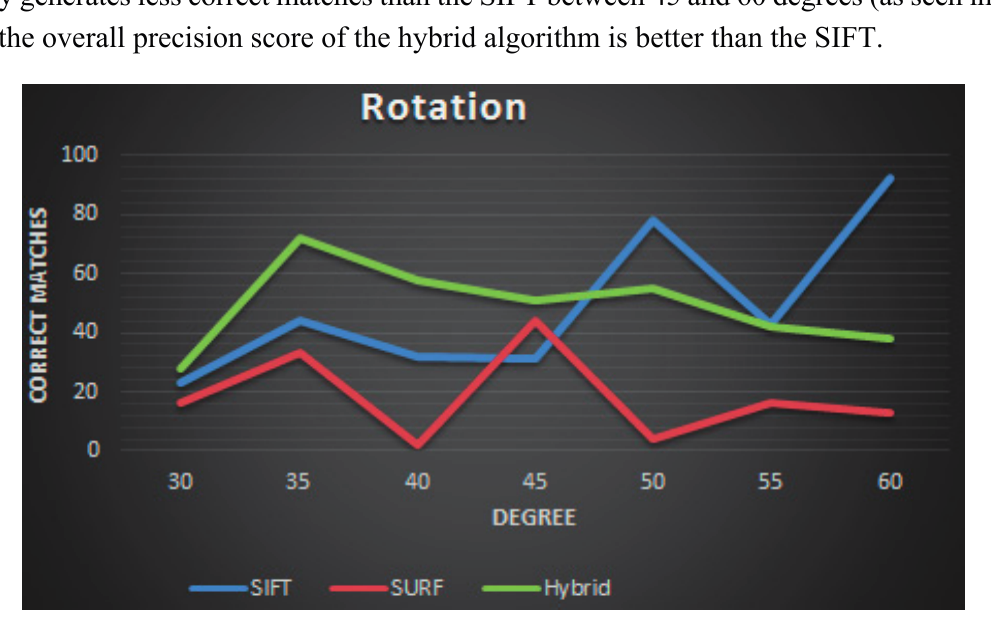
Figure 3. Rotation